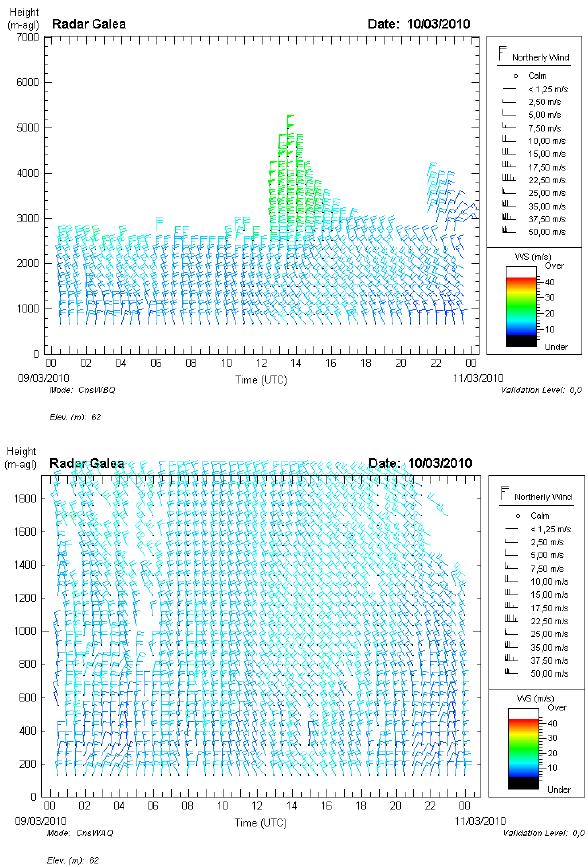
55 56 Fig. 6. North pattern: wind profiler observations on 10 March 2010. Top panel, Barb plot for 57 Fig. 6. North pattern: wind profiler observations on 10 March 2010. High mode observation with resolution of 200m. Bottom panel, Low mode observation with 58 resolution of 60m. X axis (Time UTC). Y axis (Height in meters above ground level). 59 (top) Barb plot for high mode observation with resolution of 200m. (bottom) Low mode observation with resolution of 60m. x axis (time UTC). y axis (height in ma.g.l.).